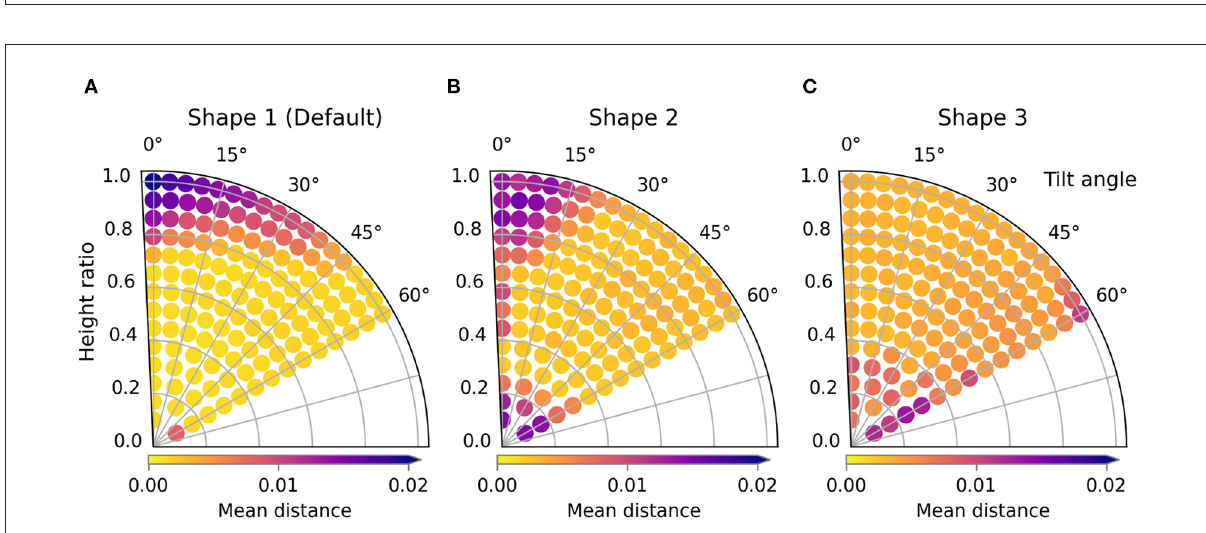
FIGURE7 Trajectory performances for the default scenario. The performance for shapes 1, 2, and 3 are shown in (A) , (B) , and (C) respectively.